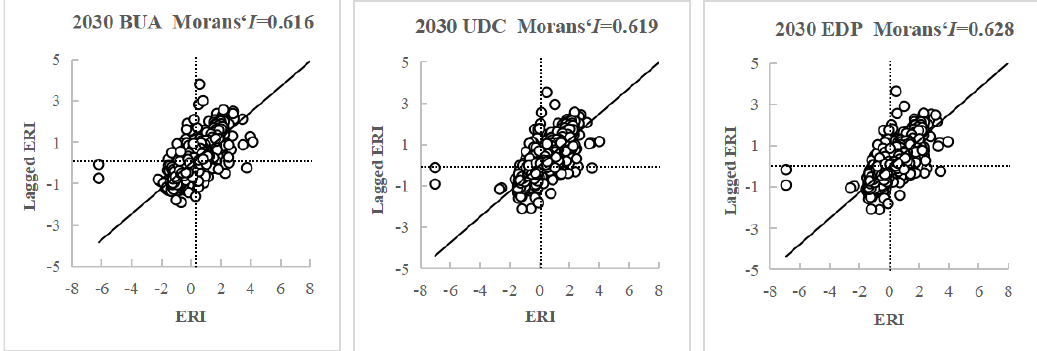
Figure 5. Global Moran’s I scatter figures of land use ERI in the Sichuan-Yunnan Ecological Barrier in 2000, 2010 and 2020.